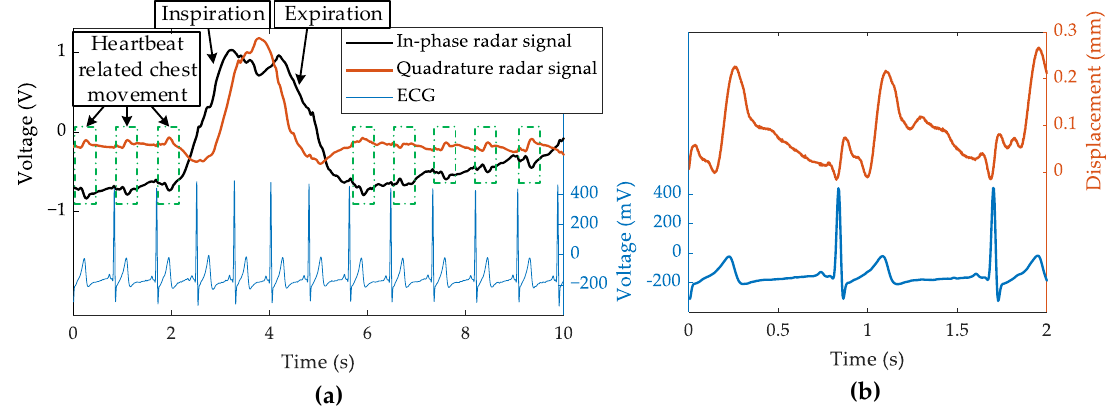
Figure 3. ( a ) A fragment of the recorded ECG and radar signals. It could be noted that the heartbeats acquired by the ECG amplifier are followed with slight movement patterns picked up by the radar. During the inhale − exhale (see 2 – 5 s) this movement pattern is distorted. ( b ) A heartbeat-related chest wall displacement obtained using the extended differentiate and cross-multiply (DACM) demodulation of the first 2 s of the radar